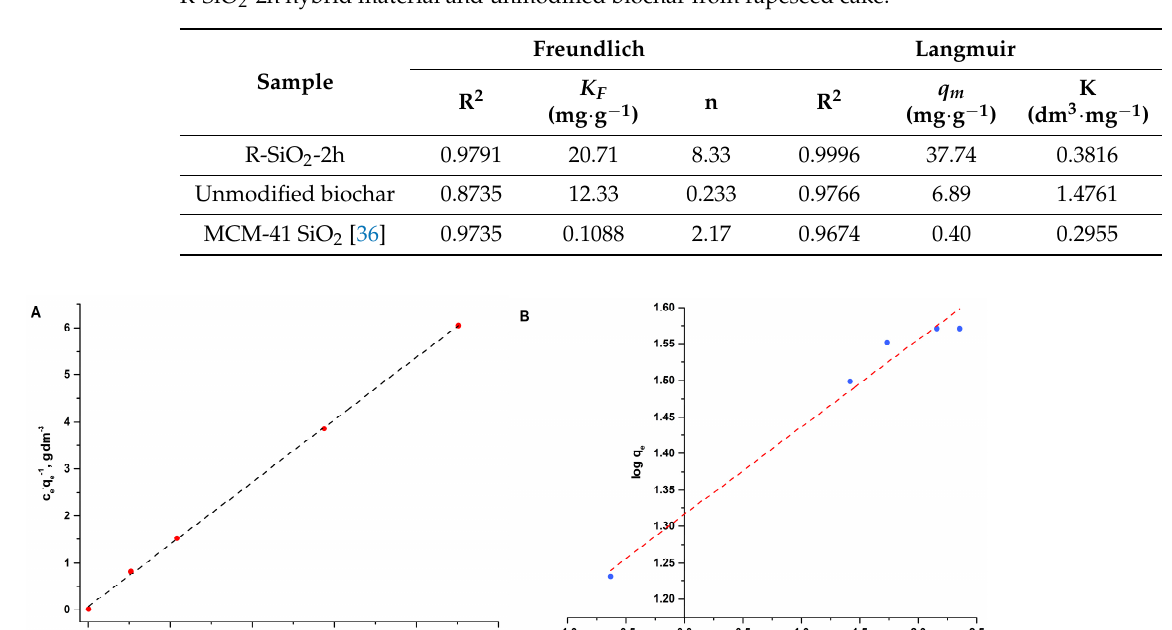
Table 4. Freundlich and Langmuir isotherms parameters for adsorption of copper(II) ions onto R-SiO 2 -2h hybrid material and unmodified biochar from rapeseed cake.